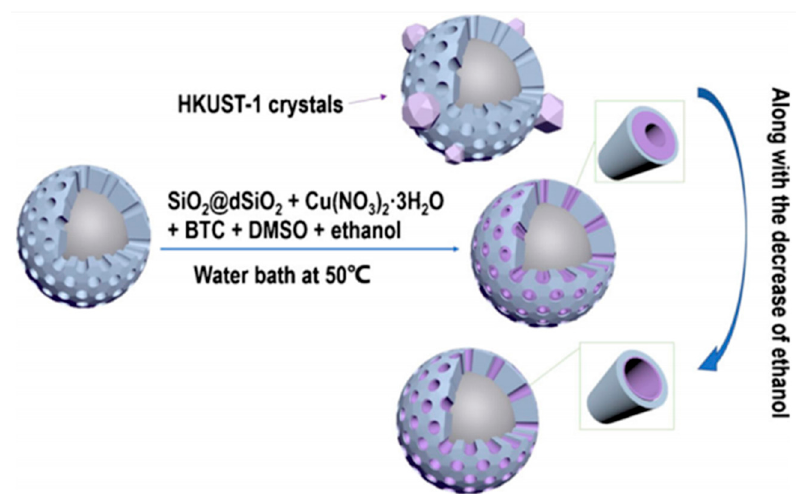
Figure 4. A schematic pathway for the modification of core-shell silica particles with HKUST-1 crystals. Reproduced from from [94], with permission from Springer, 2014.